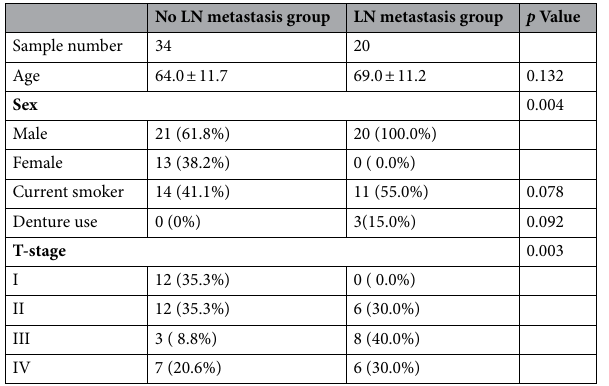
Table 1. Baseline characteristics of enrolled oral squamous cell carcinoma patients. LN: lymph